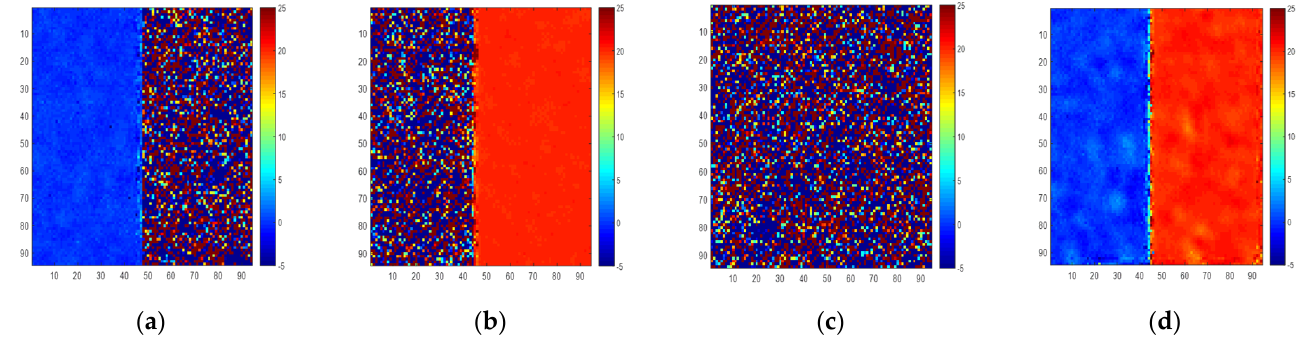
Figure 13. Simulated height inversion. ( a ) Single scattering. ( b ) Double scattering of 0 degrees. ( c ) Double scattering of 45 degrees. ( d ) Polarimetric interferometric optimal decomposition.